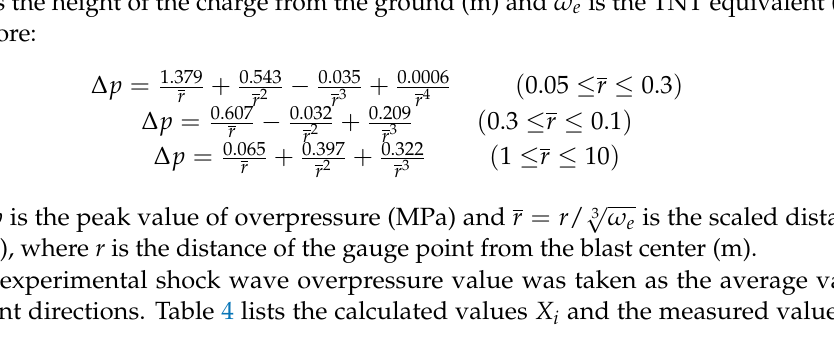
Table 4. Comparison of the static explosion overpressure between the test and calculation results. r 2 3 ∆ p